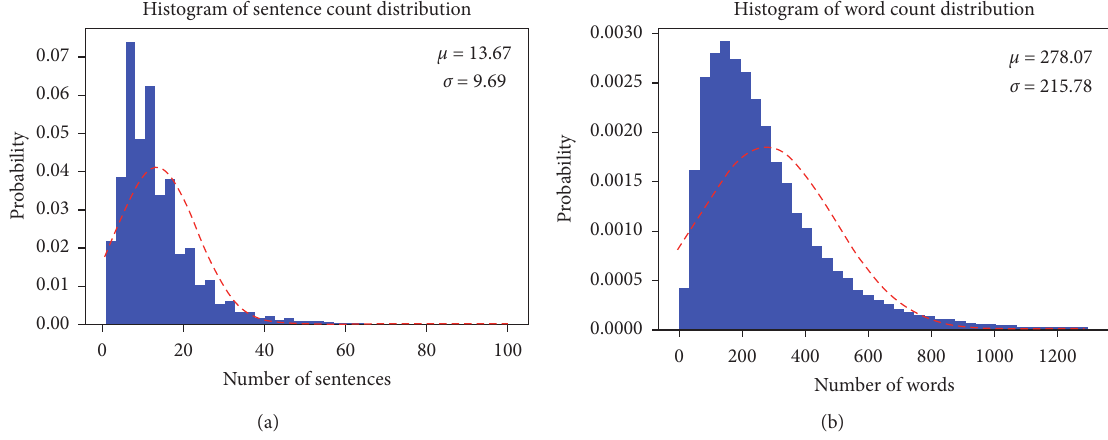
Figure 2: Distributions of lengths of incident reports based on the number of sentences and words. Table 3: There are sixteen primary causal factors identified by the human experts in the